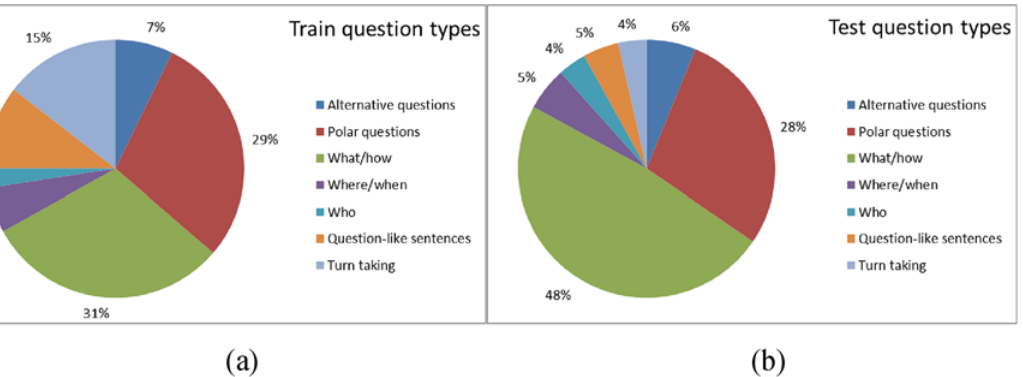
Fig 7. Distribution of the questions used for training (a) and for test (b) among the question categories: alternative (choice) questions, polar ( yes/ no ) questions, what/how questions, where/when questions, who questions, question-like imperative sentences (e.g. tell me ), conversational sentences that expect a turn taking from the system.